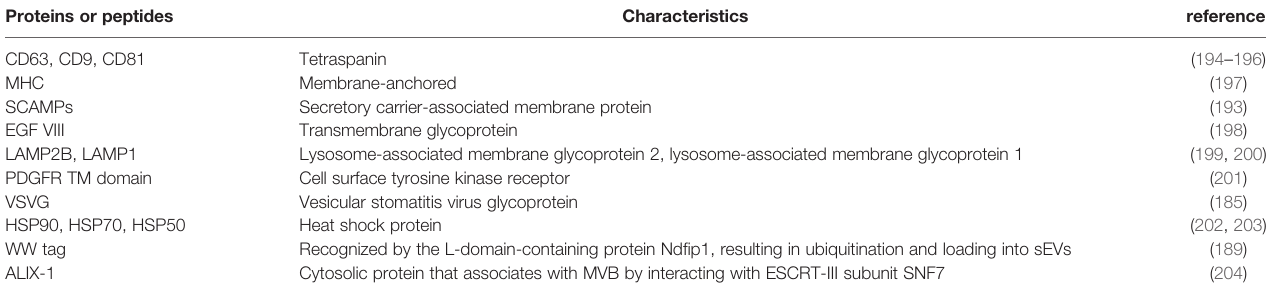
TABLE 2 | Proteins or peptides providing potential modi fi cation targets to load therapeutic agents. Proteins or